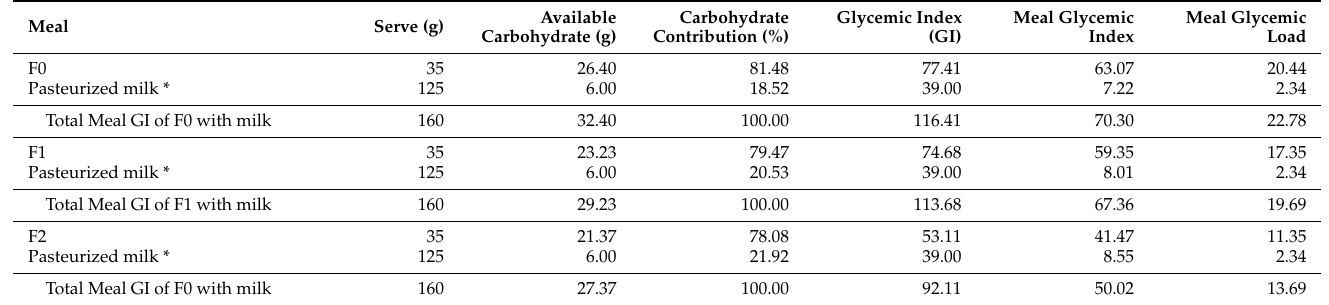
Table 6. Glycemic index and glycemic load of extruded purple sweet potatoes.